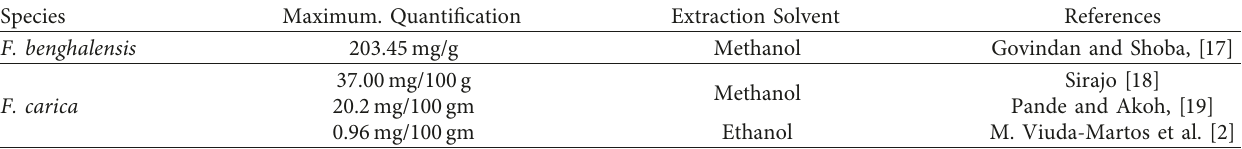
Table 1: Ascorbic acid vitamin C present in the species used as both fresh fruit and spices belonging to genus Ficus .